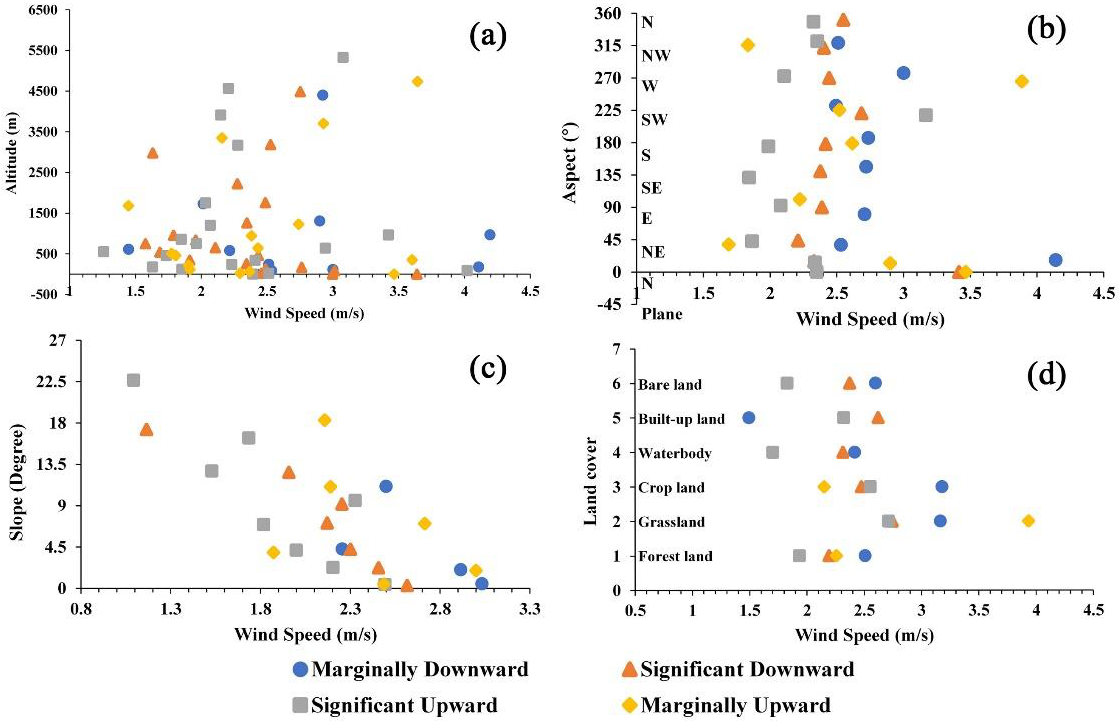
Figure 11. The relationship between the wind speed and different environmental factors: ( a ) altitude; ( b ) aspect; ( c ) slope; ( d ) land